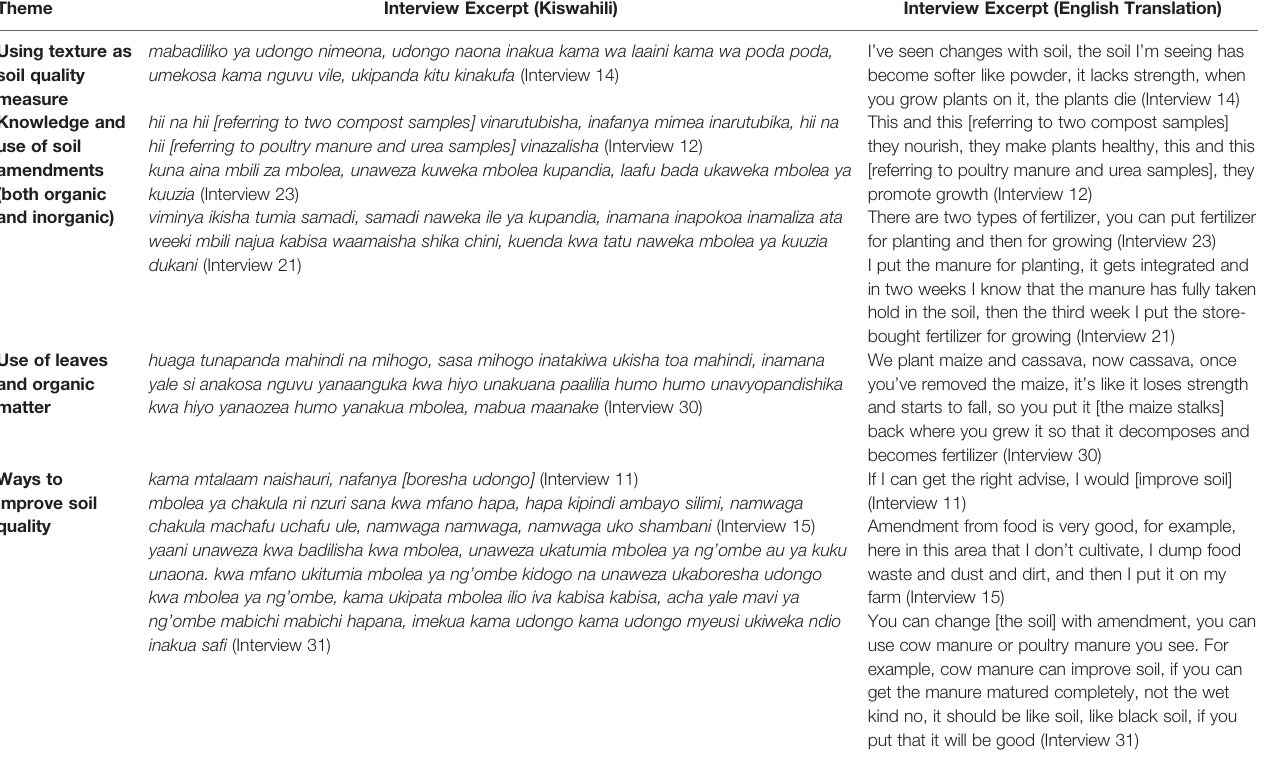
TABLE 4 | Excerpts from interviews that express the perspectives of soil fertility and use of amendments among urban farmers in Mwanza,